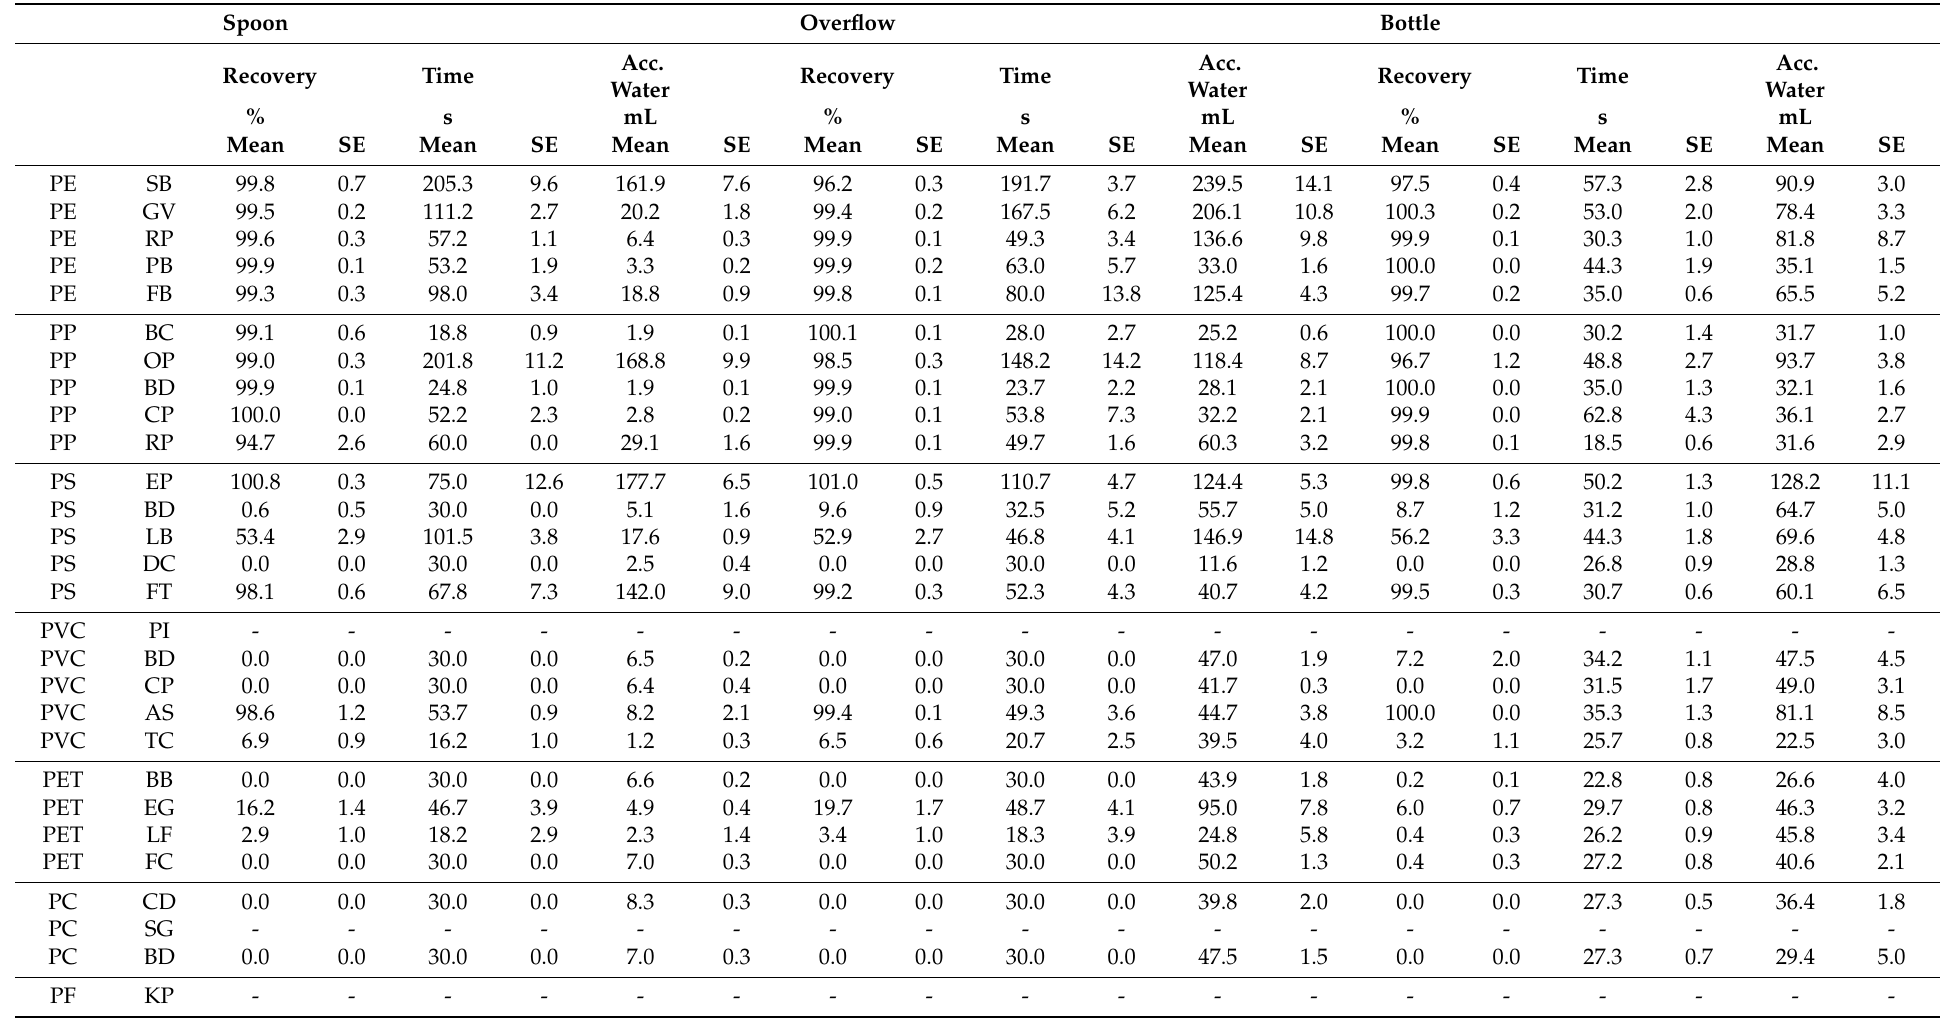
Table 2. The recovery efficiency of each sorting method (recovery rate, required time, amount of accompanying water) (tap water, n =